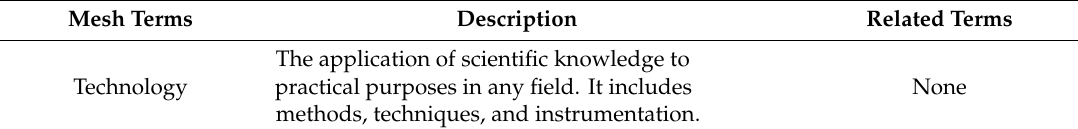
Table 1. MeSH (Medical Subject Heading) terms and